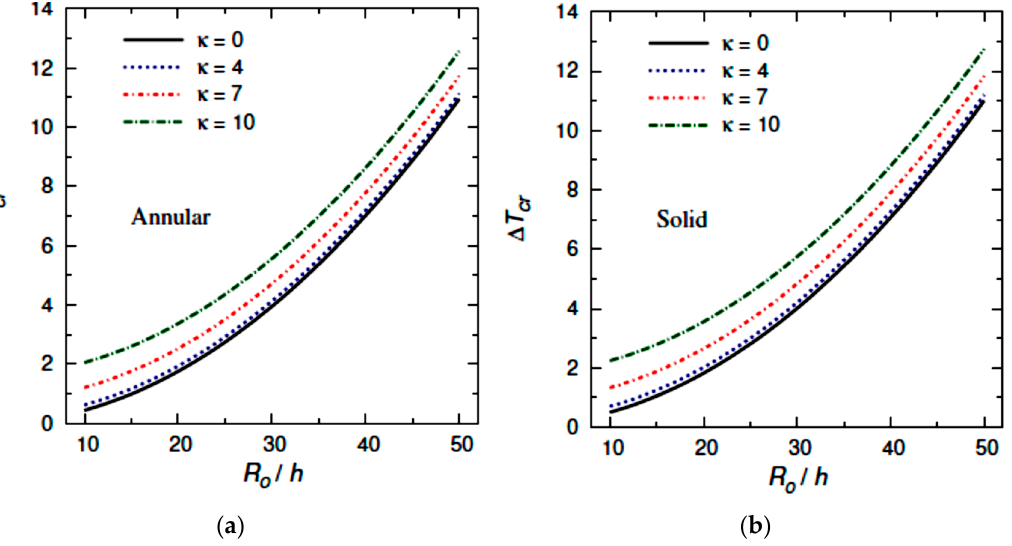
Figure 4. Effects of the outer radius to thickness ratio 𝑅 (cid:3042) /ℎ and number of nodal diameter 𝜅 on the critical buckling temperature Δ𝑇 (cid:3030)(cid:3045) of simply supported SGP ( a ) annular and ( b ) solid circular plates ( 𝑅 (cid:3036) /𝑅 (cid:3042) = 0.3 , 𝐸 (cid:3085) = 0.05 V/m , 𝑤 (cid:3034) = 0.1% , 𝜇 = 𝛾 = 2 nm , Δ𝐶 = 0.5% , 𝑒 (cid:2868) = 3 × 10 (cid:2873) , 𝐽 (cid:2869) = 100 , 𝐽 (cid:2870) = 10 ).